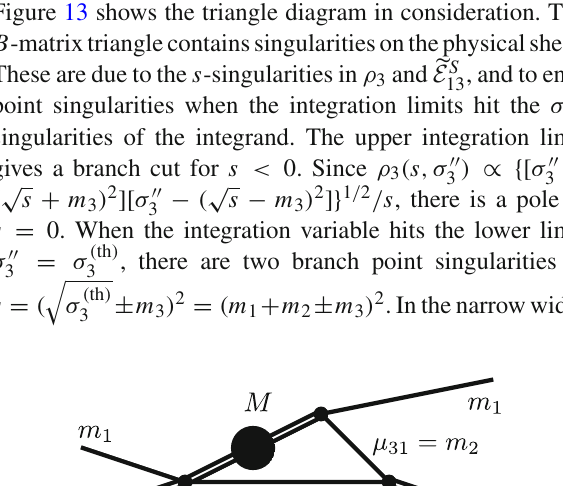
Fig. 14 Motion of the σ (cid:6)(cid:6) ( ± ) in the σ (cid:6)(cid:6) -plane as a function of s for fixed 3 3 (cid:6)(cid:6) ( − ) σ σ (cid:6)(cid:6) ( + ) andinblue σ .Thepointsindicatevarious s 1 .Showninredis 3 3 valuesstartingfromthethreeparticlethreshold, s = ( m 1 + m 2 + m 3 ) 2 = 9. The inset shows that the branch points pinch the real σ (cid:6) √ σ + m ) 2 = 16, which is responsible for a pinch singularity in s = ( 1 1